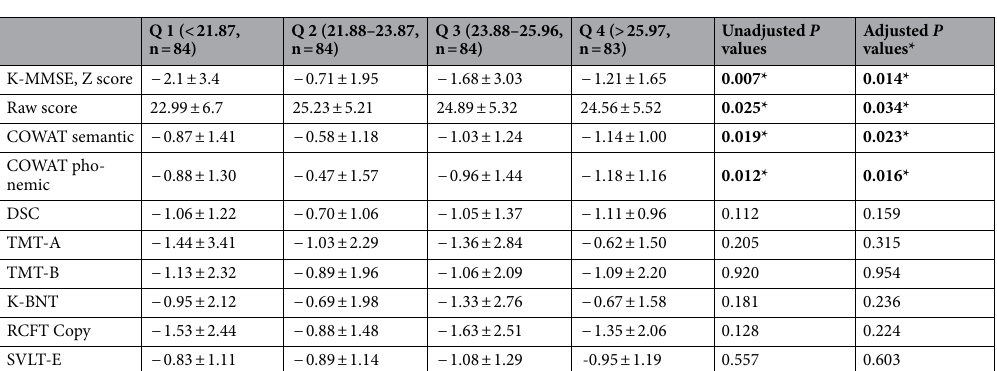
Table 2. Comparison of Z scores of cognitive tests according to the quartiles of body mass index. Adjusted for the initial stroke severity (National Institute of Health Stroke Scale). Bold values followed by * are significant at α = 0.05. K-MMSE Korean Mini-Mental Status Examination; COWAT Controlled Oral Word Association Test; DSC Digit Symbol Coding; TMT Trail Making Test; K-BNT Korean version-Boston Naming Test; RCFT Rey Complex Figure Test; SVLT-E Seoul Verbal Learning Test-Elderly’s version.